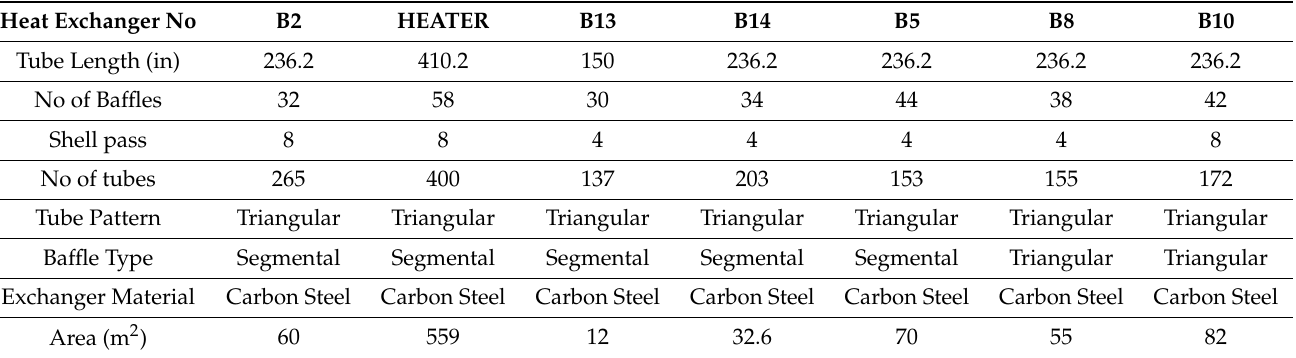
Table 8. Mechanical Design of Heat Exchangers.